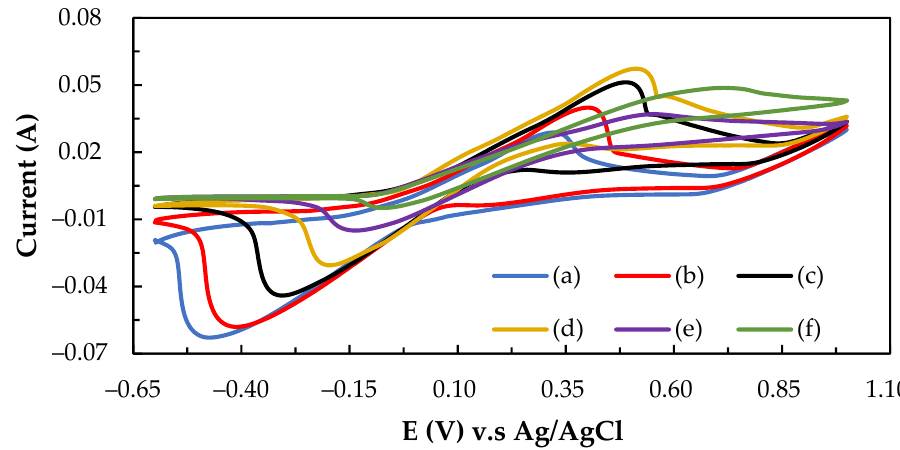
Figure 3. The effect of adding ascorbic acid on the electrochemical properties of I 2 /ascorbic